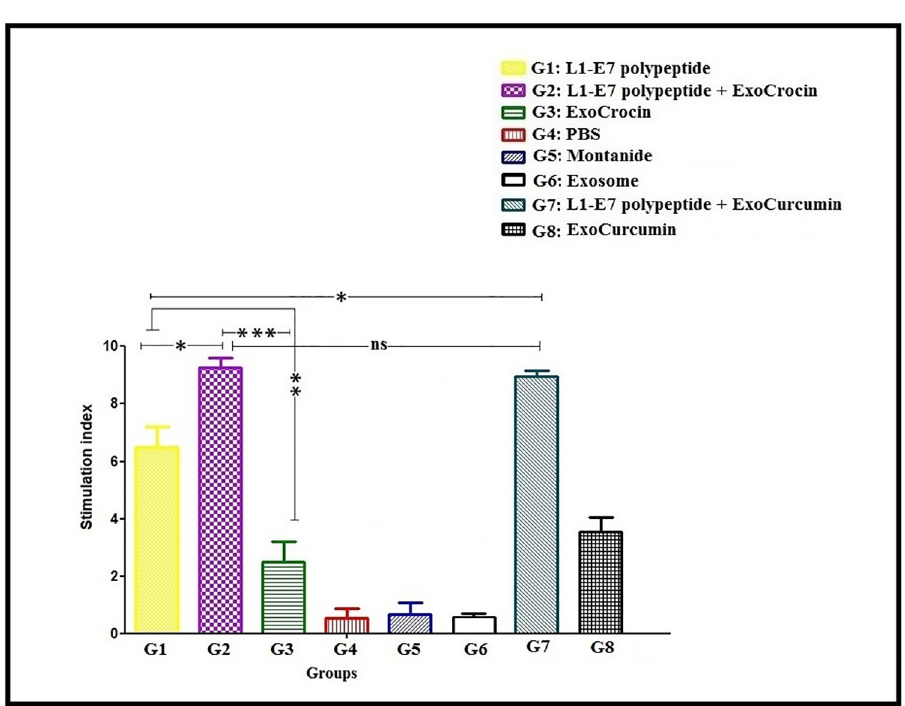
Fig 7. The lymphocyte proliferation assay in immunized groups with different regimens using MTT assay; ns: Non-significant; � p < 0.05; �� p < 0.01; ��� p < 0.001.